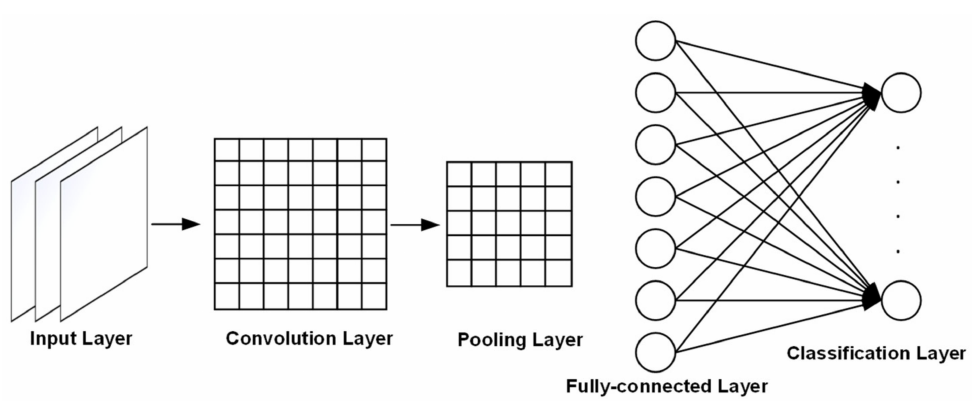
Figure 5. Structure of convolutional neural network